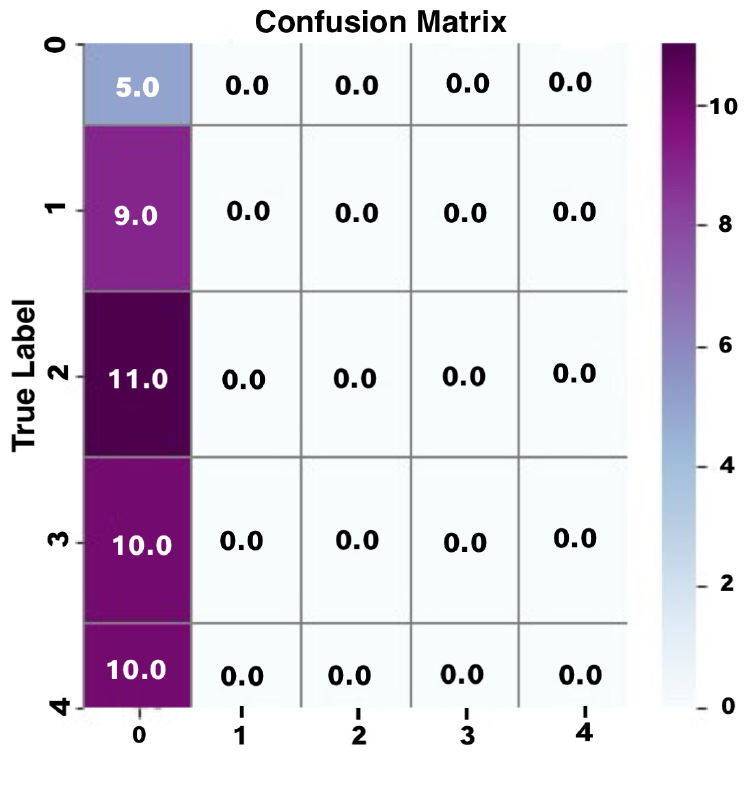
Figure 22. Confusion matrix for the second LSTM